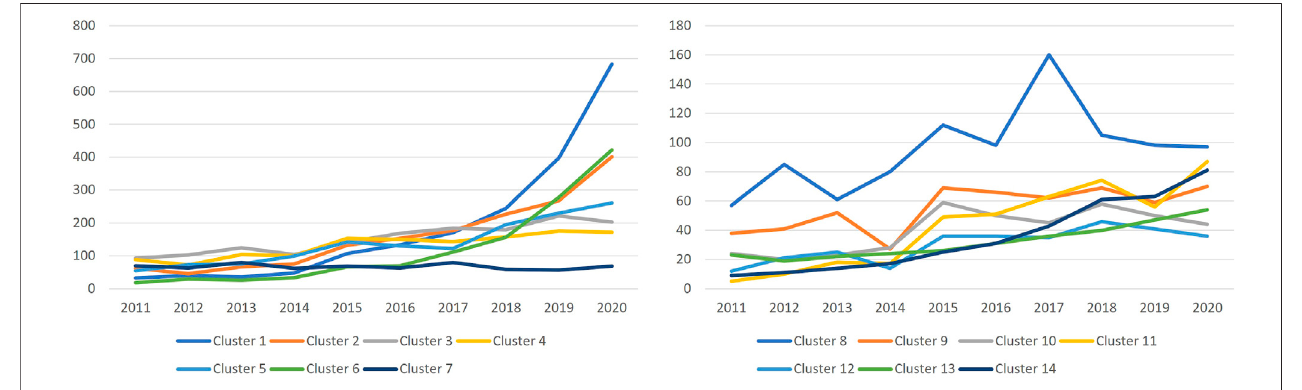
FIGURE 5 | Yearly publications per cluster from 2001 to